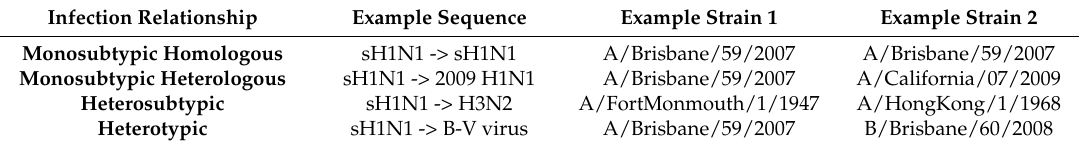
Figure 1. Influenza immune background development following recurrent infections and vaccinations. The schematic illustrates possible immune fluctuations following influenza virus infection or vaccination. Immune fluctuations and potential protection can be conceptualized at both the individual or population level. The heterogeneity of the immune background is dependent on the sequence of virus exposures and their genetic and antigenic relatedness. Immune specificity that is gained during influenza virus immune imprinting during infancy or childhood leading to the generation of virus-specific T and B cells are retained at some level throughout life. T = T cell; B = B cells; Y = antibodies. Table 1. Influenza virus relationships of sequential infection.